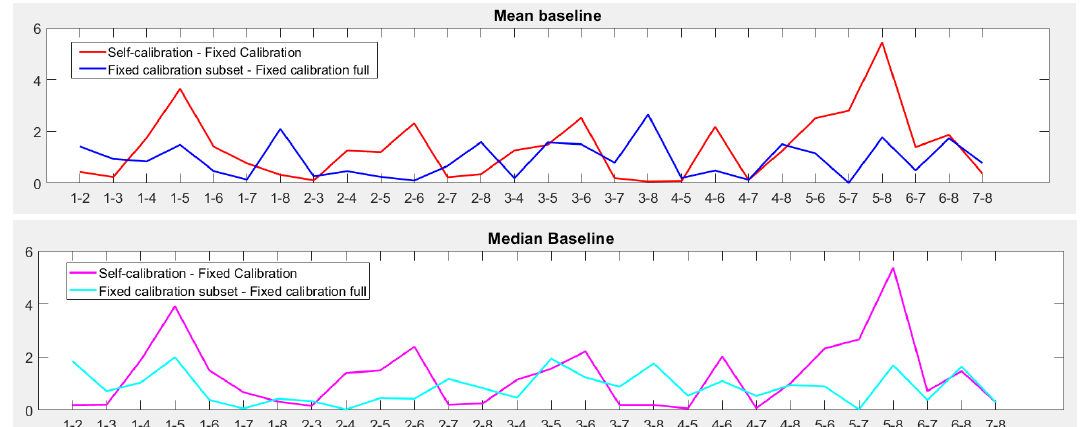
Figure 8. Absolute difference (in mm) between the three different approaches, taking as reference the fixed calibration full dataset. The results are reported for the constrained